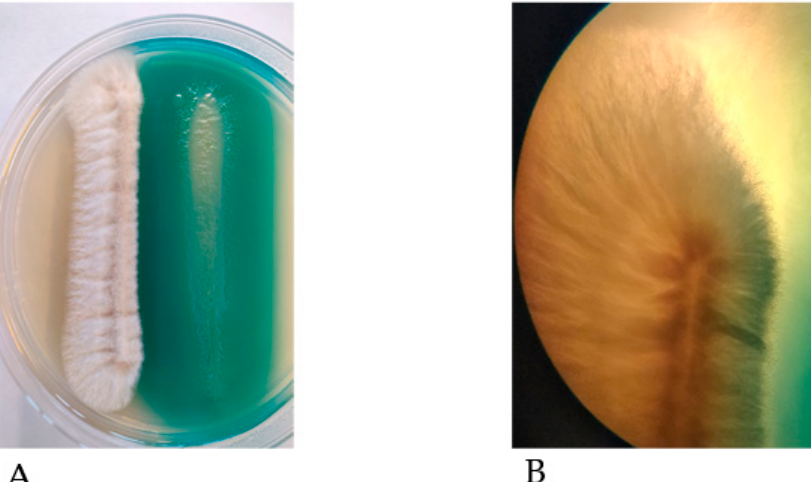
Figure 1. ( A ) P. aeruginosa cells (right) grown alongside A. fumigatus conidia (left) on nutrient agar. P. aeruginosa inhibits growth of A. fumigatus as evidenced by reduced mycelial expansion on the side of bacterial growth. The green pigment produced by P. aeruginosa is pyocyanin. ( B ) A magnified image of (A) in which A. fumigatus growth is inhibited by P. aeruginosa ; the expansion of A. fumigatus mycelia are inhibited by the close proximity to P. aeruginosa cells. By contrast, the absence of bacteria on the left hand side of the fungus allow mycelia to expand outward.